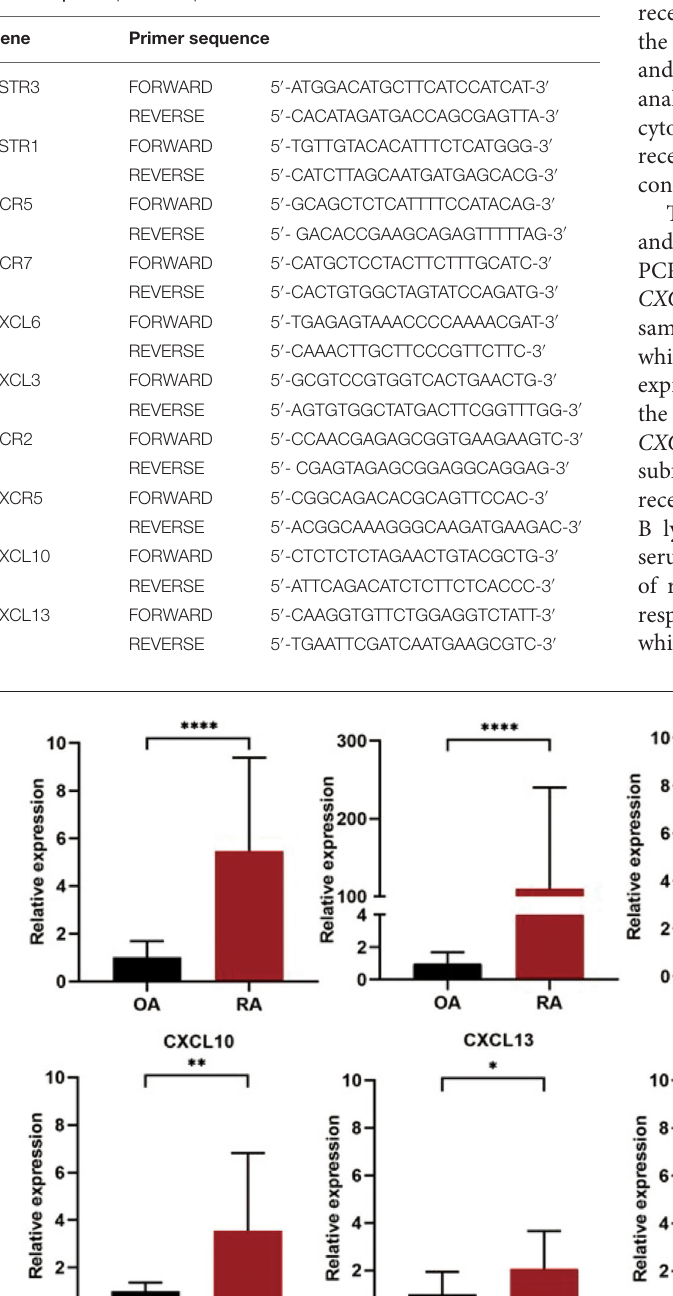
TABLE 4 | Gene primer sequences.